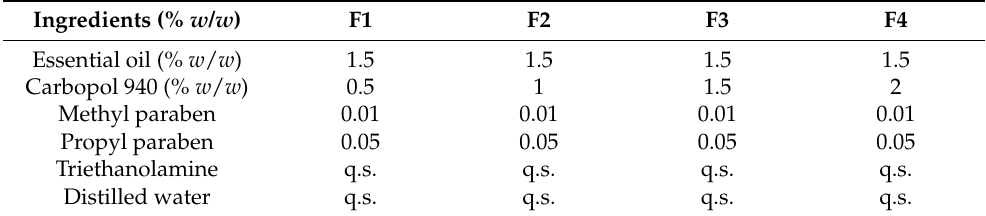
Table 12. Composition of the four formulations of nanoemulgel. Ingredients (% w / w ) F1 F2 F3 F4 Essential oil (% w / w ) 1.5 1.5 1.5 1.5 Carbopol 940 (% w / w ) 0.5 1 1.5 2 Methyl paraben 0.01 0.01 0.01 0.01 Propyl paraben 0.05 0.05 0.05 0.05 Triethanolamine q.s. q.s. q.s. q.s. Distilled water q.s. q.s.